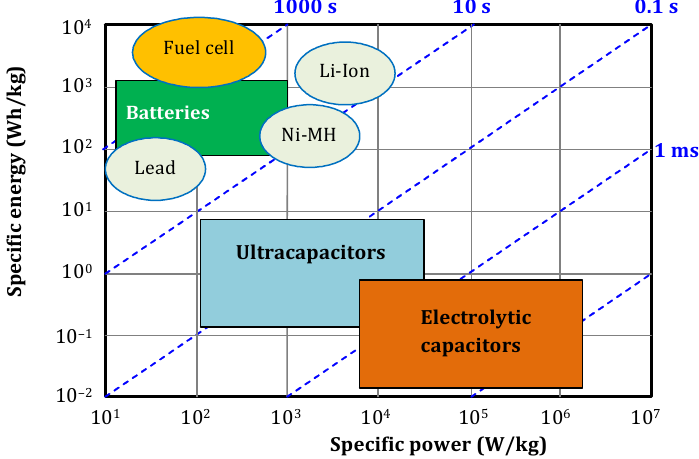
Figure 1. Specific energy vs. specific power of energy storage system [3].